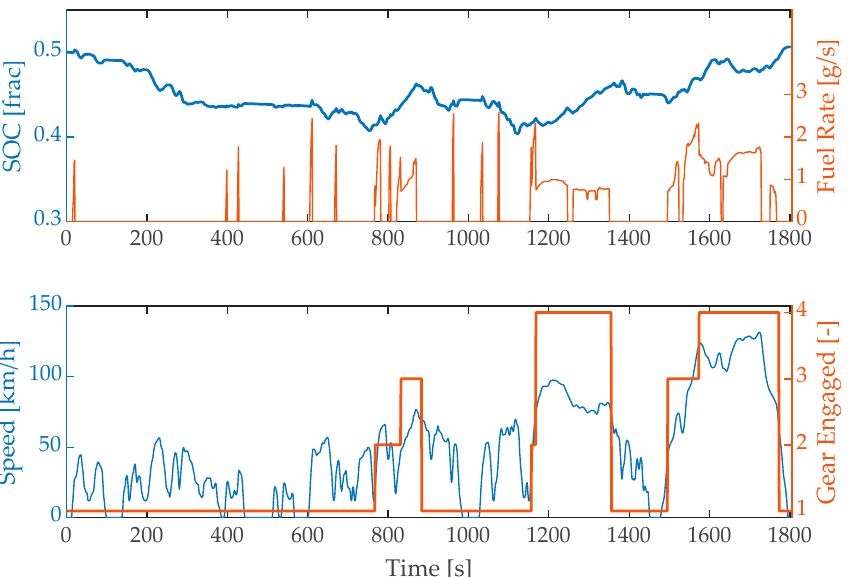
Figure 7. Example of the DP control results for a four-speed HEV driving the WLTP, equipped with a 99 kW ICE and a 29 kW EM.